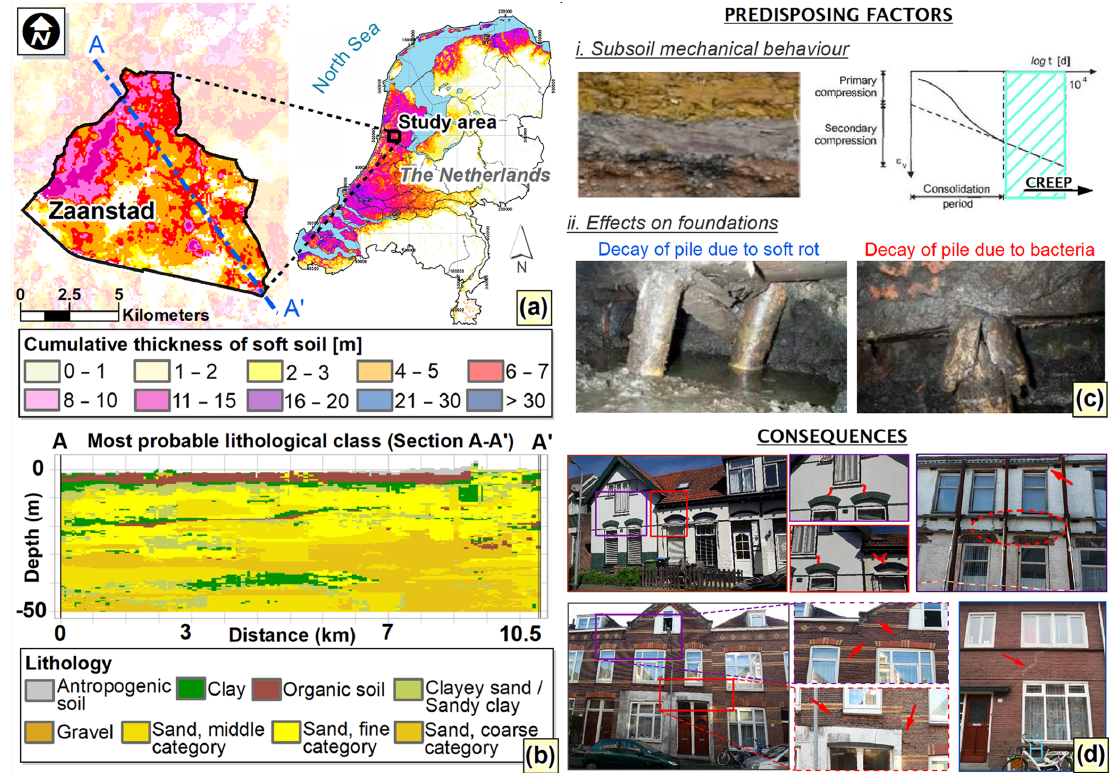
Figure 1. Zaanstad case study with (a) cumulative thickness of soft soils (organic and clayey) courtesy of Deltares; (b) geological cross- section (extracted from the portal of the Geological Survey of the Netherlands – DINOloket); (c) predisposing factors to settlements occur- rence and (d) consequences in terms of damages to buildings.